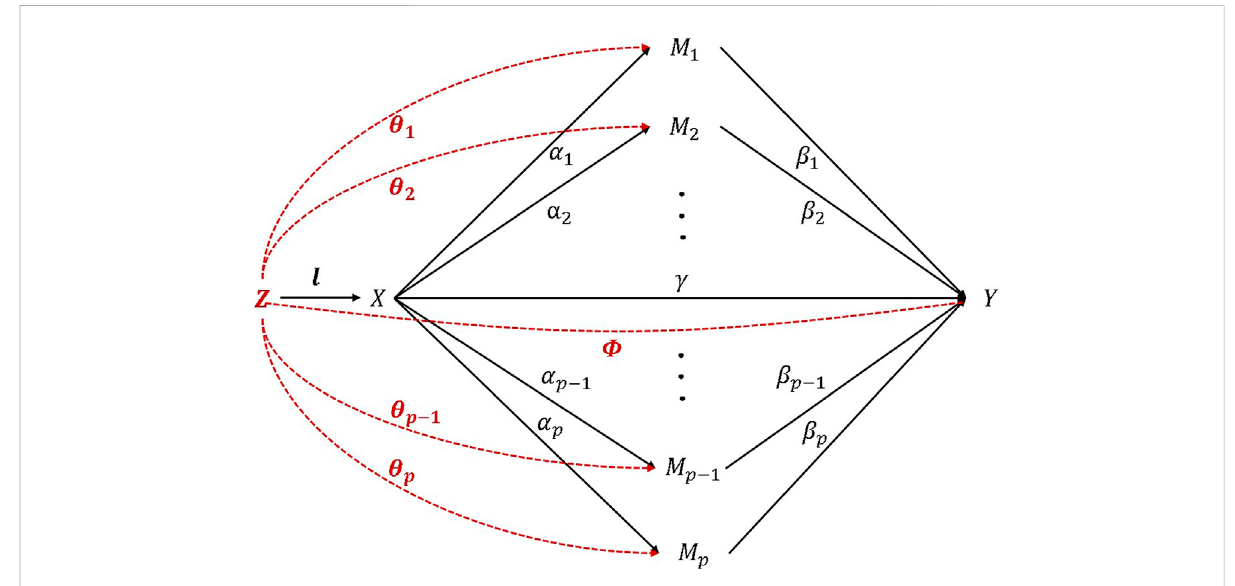
FIGURE 1 High-dimensional mediation model with